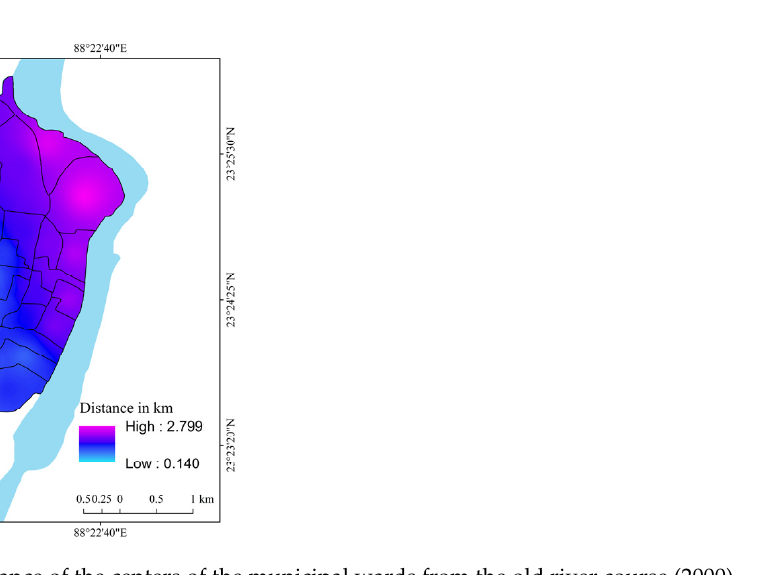
Figure 25. NDTI (2000).